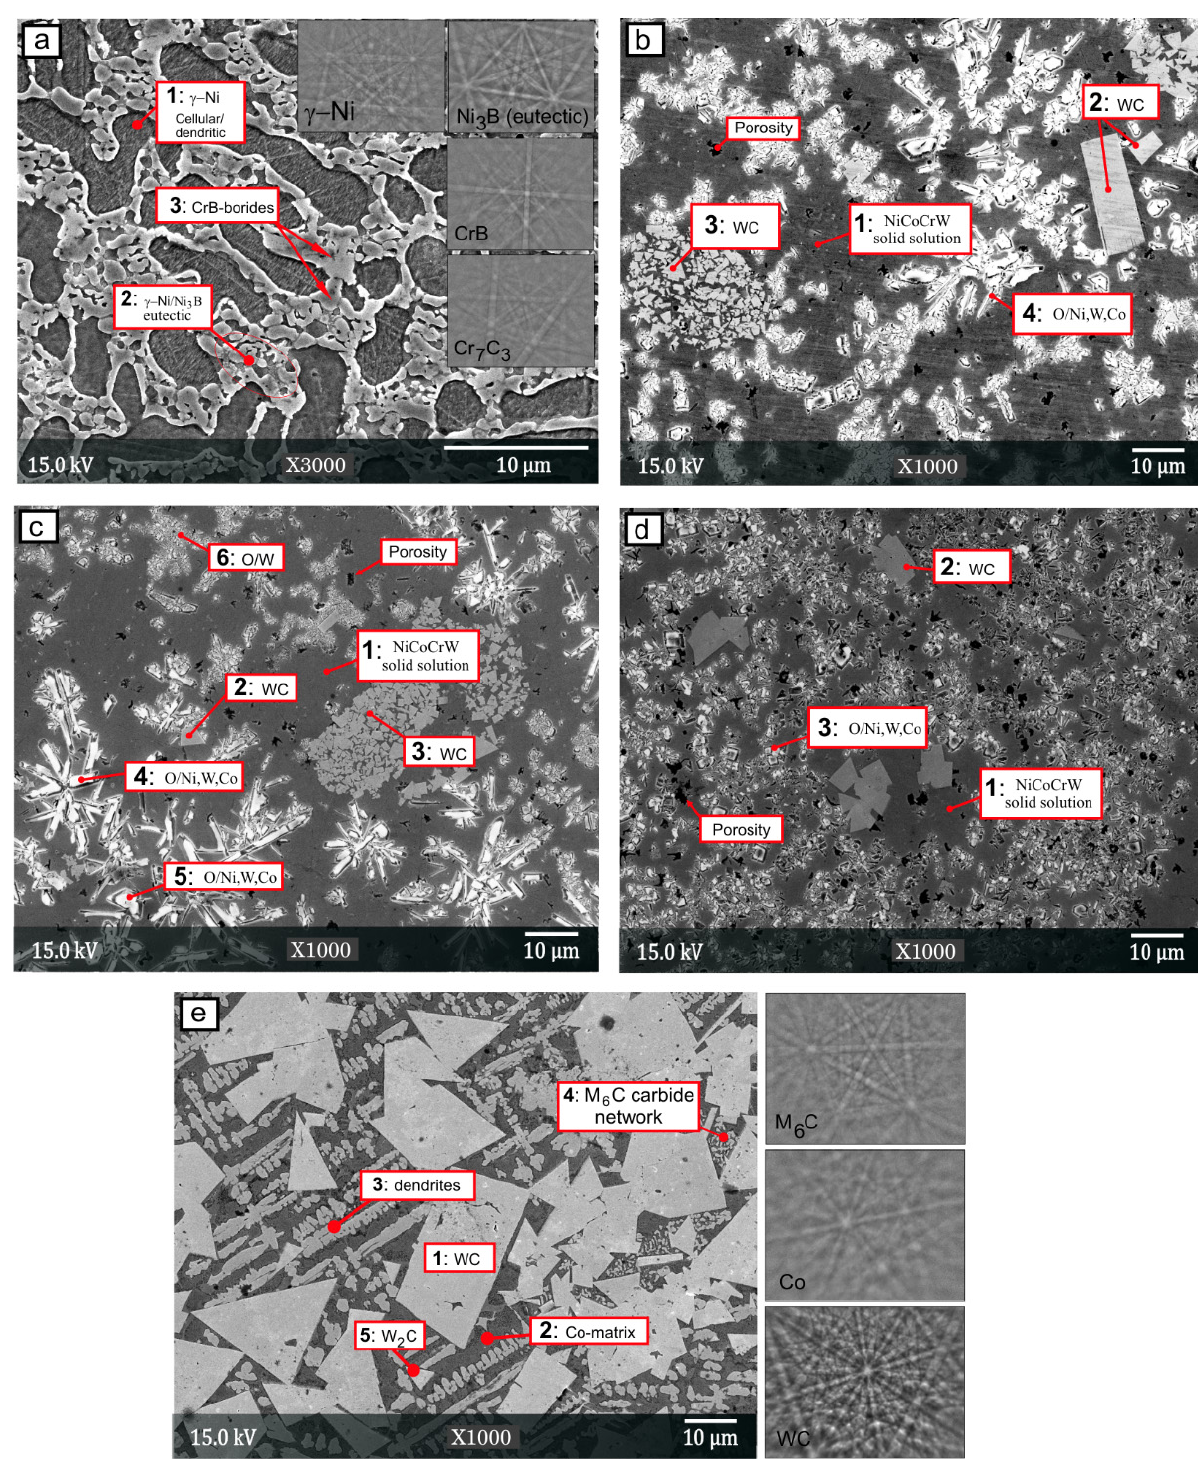
Figure 5. Microstructures of laser cladded coatings and Kikuchi patterns: ( a ) NiCrBSi, ( b ) NiCrBSi + 30 wt.% WC-12Co, ( c ) NiCrBSi + 40 wt.% WC-12Co, ( d ) NiCrBSi + 50 wt.% WC-12Co and ( e ) WC-12Co.